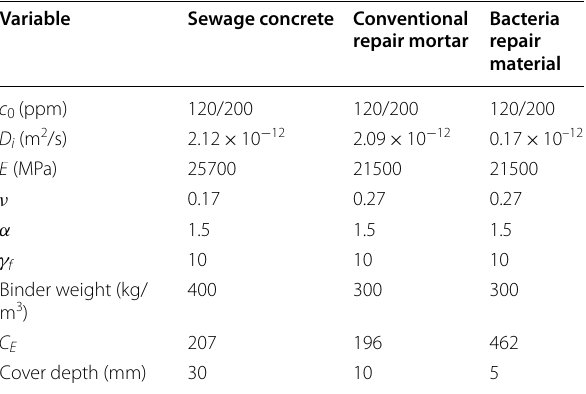
Table 1 Design parameters for sewage concrete, conventional repair, and bacteria repair materials.